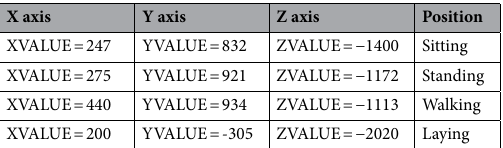
Table 2. Results from position sensor under different